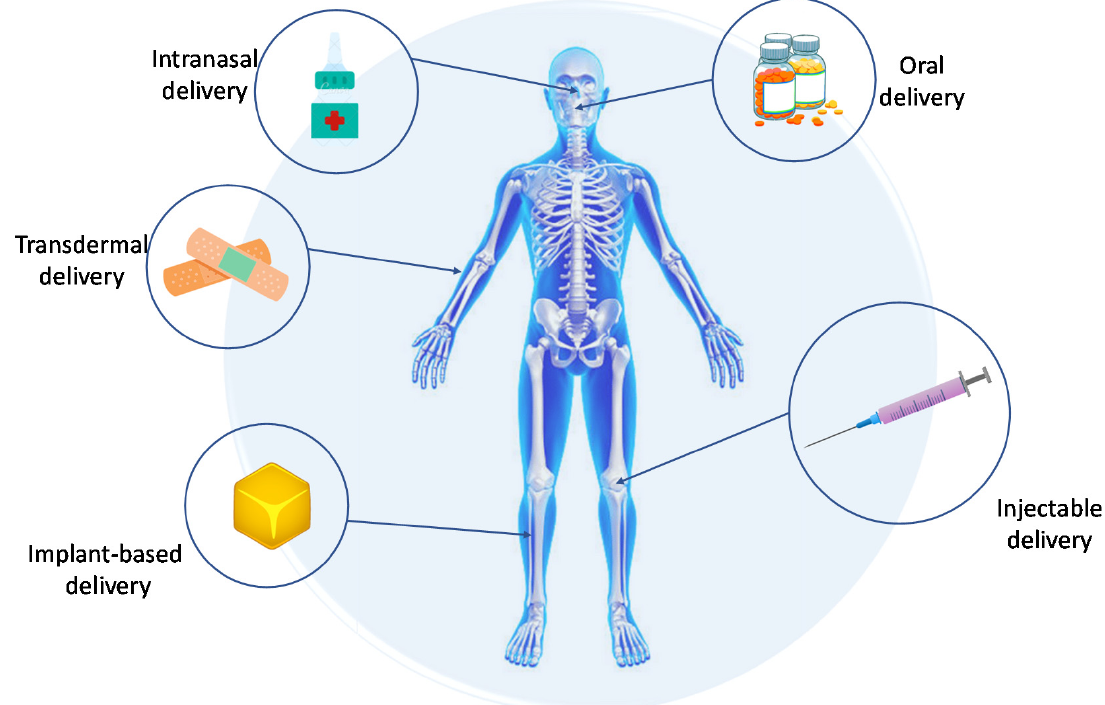
Figure 1. Strategies for delivery of biomolecules.